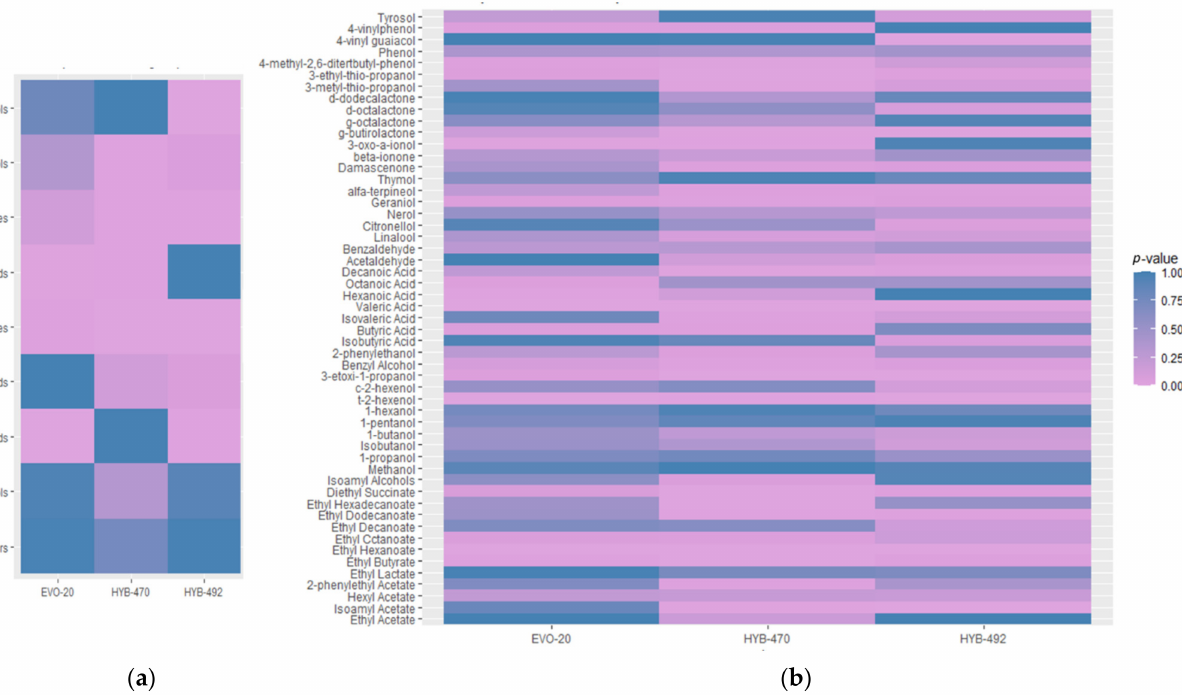
Figure 4. Heatmap representation of the significance of the volatile profile of the different wines obtained at an industrial scale compared to the control strain (UCA-Y-001): ( a ) chemical groups; ( b ) individual compounds. Significances were found according to ANOVA and Tukey’s test ( p -value ≤ 0.05 is pale rose) compared with the control one. The palette turns blue when no differ- ences were found between wines fermented with the evolved yeast strains and the control